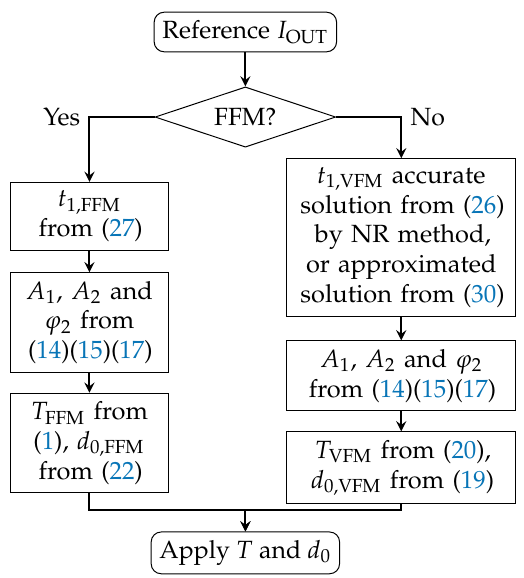
Figure 5. Control Flow Chart for the Proposed